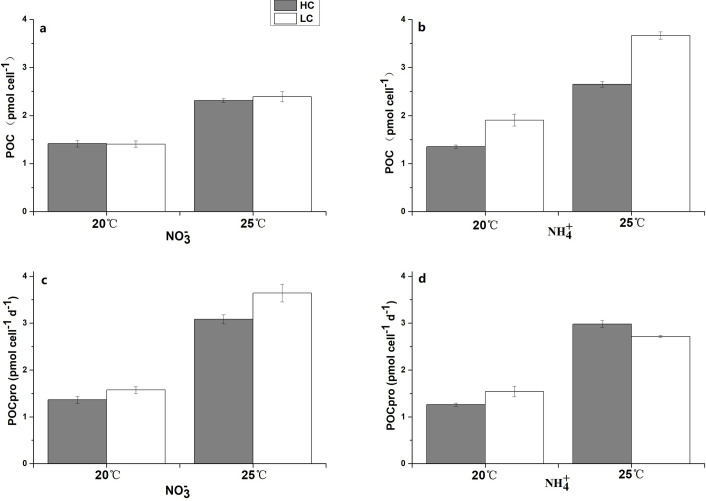
POC (a, b) and POC production rate (c, d) in NO3— and NH4+-grown cultures under HC (1000 μatm) and LC (400 μatm) at 20°C and 25°C. The values are the means and error bars are standard deviations for triplicate cultures at each treatment (p<0.05).